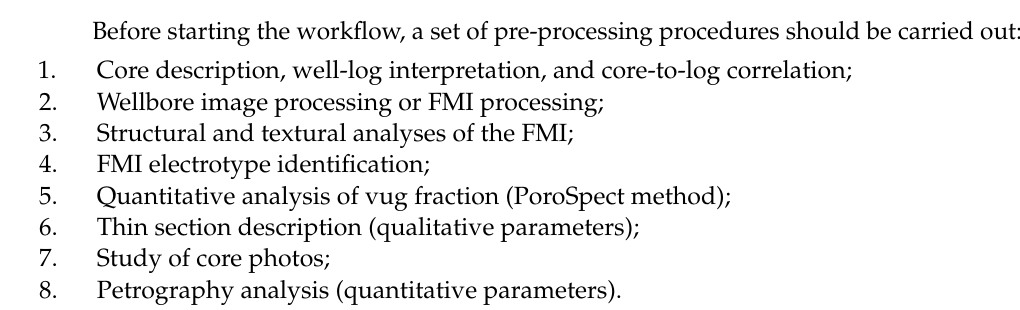
Figure 1. Overview of the rock-typing process. The pyramid shape indicates the amount of time spent on each step of the workflow. The first two steps are the most time-consuming, due to the great number of routine procedures.